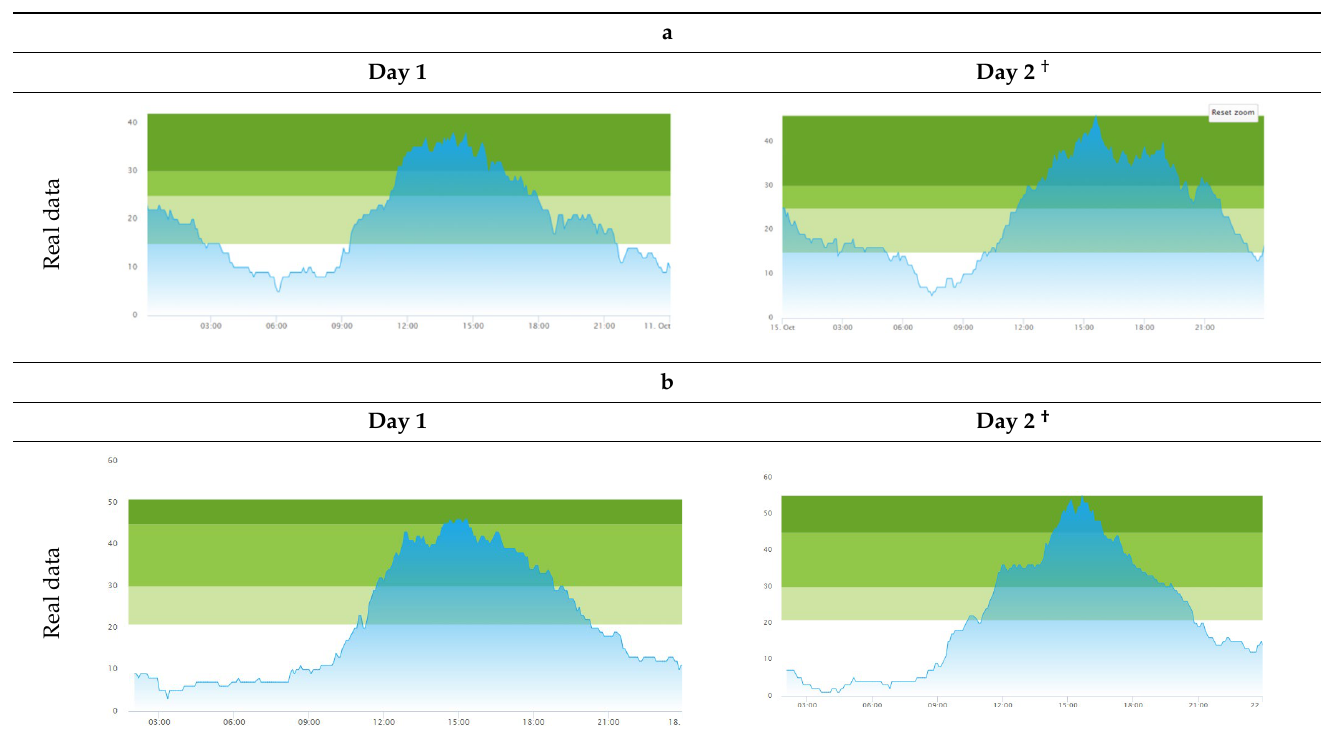
Table 1. a. Patient crowding in the ED gathered from Smart Crowding for two regular days in a pre-pandemic situation. b. Patient crowding in the ED gathered from Smart Crowding for two separate days in a peri-pandemic